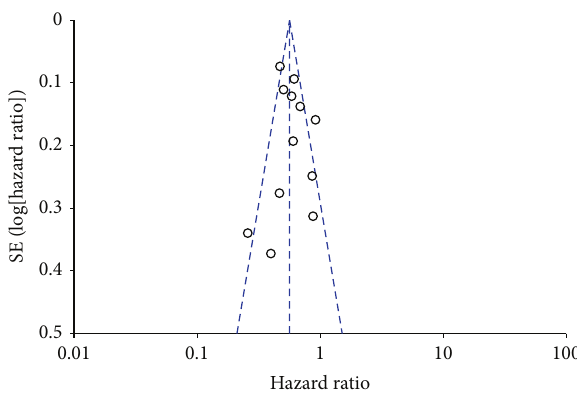
Figure 5: Funnel plot at 3-year overall-survival depicting the distribution of hazard ratios for the 12 studies included in the meta- analysis. The outer dashed lines indicate the triangular region within which 95% of studies are expected to lie in the absence of reporting biases and heterogeneity. The solid vertical lines correspond to no intervention